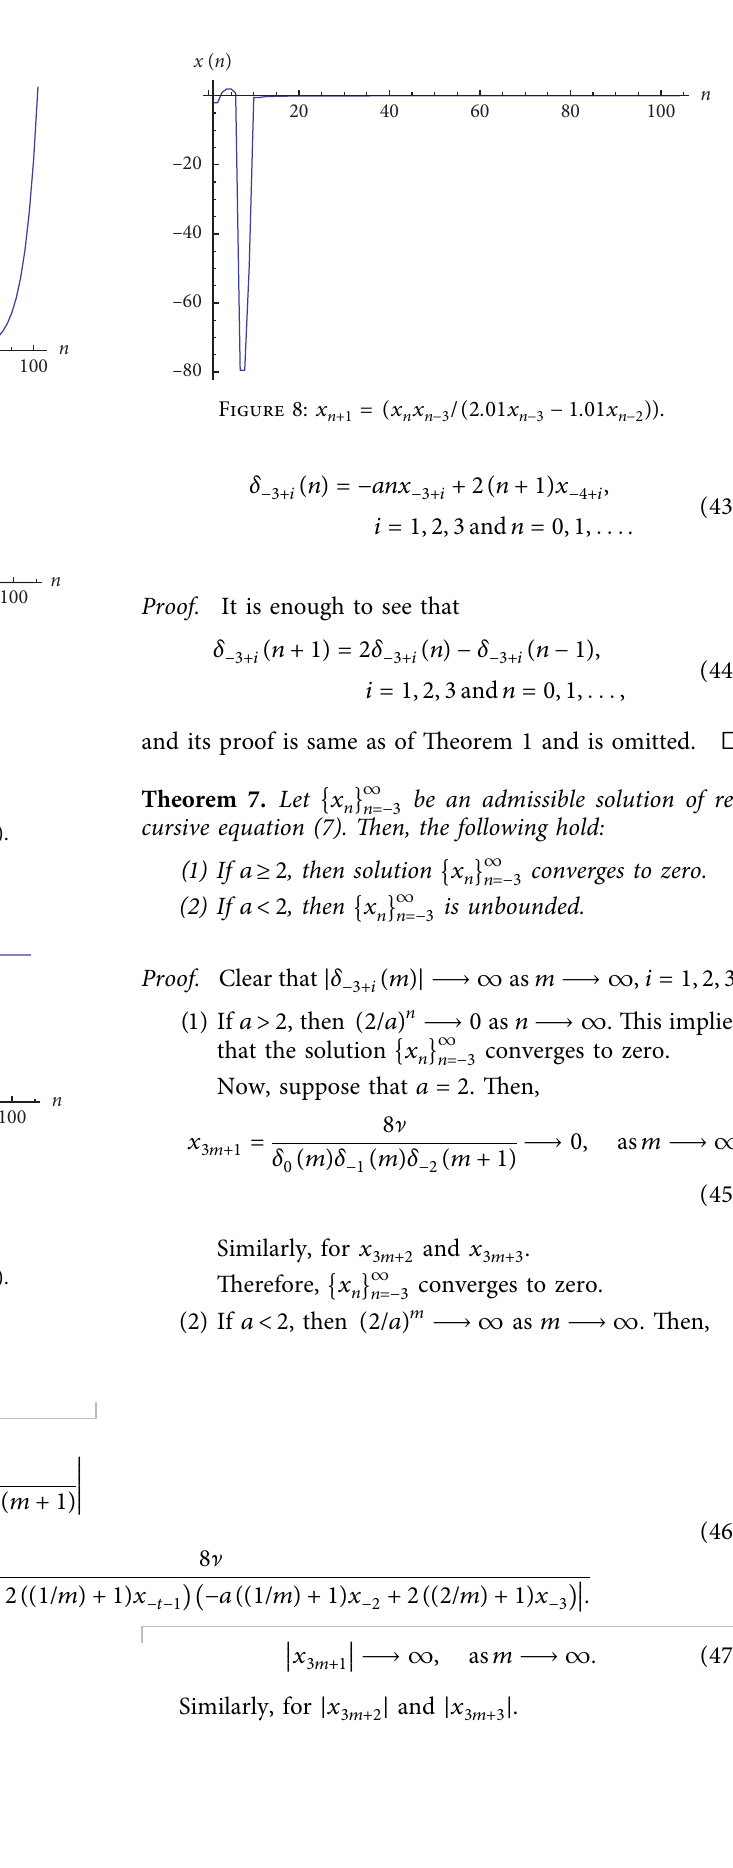
x ( x − 0 . 2 x n n − 3 / n − 3